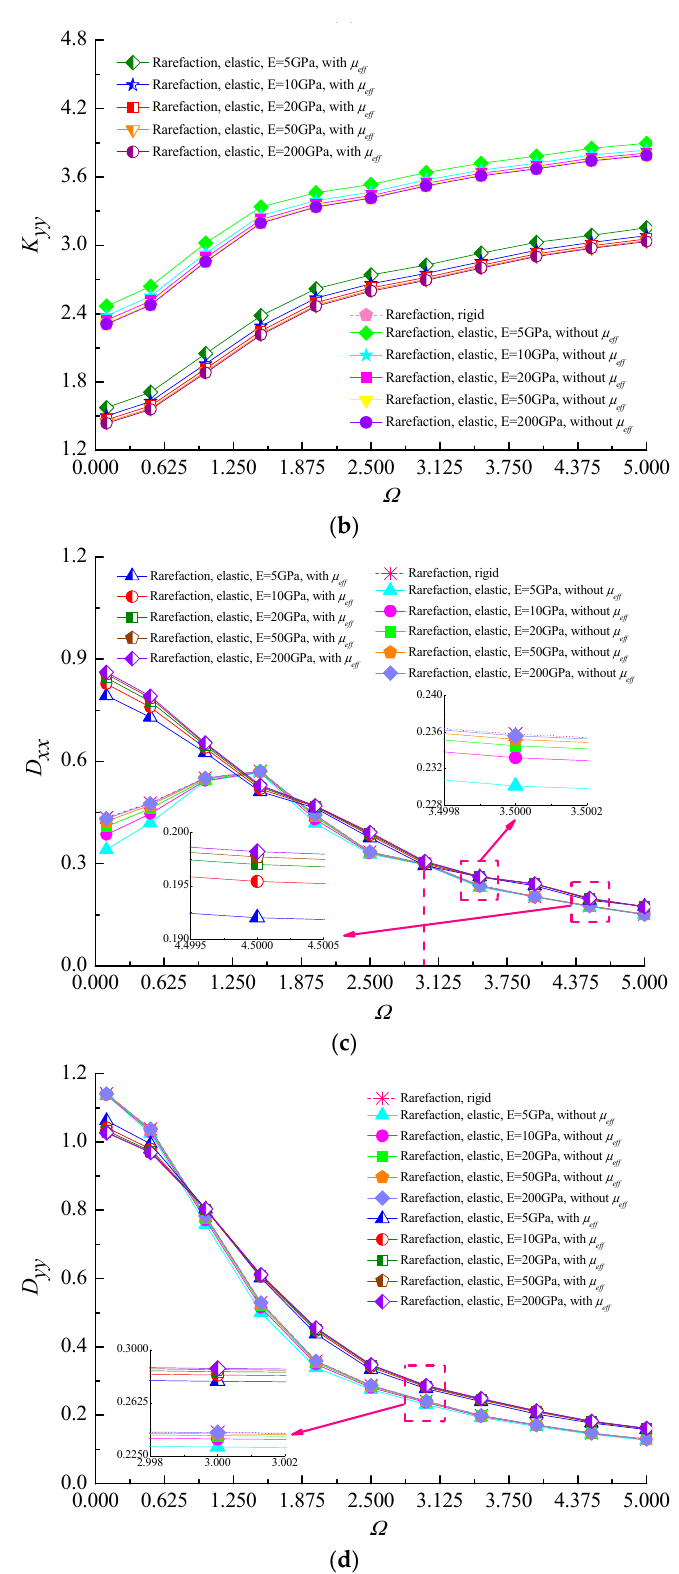
Figure 9. Variation of dynamic stiffness and damping coefficients with the perturbation frequency for different moduli of elasticity of liner material. ( a ) K xx vs. Ω ; ( b ) K yy vs. Ω ; ( c ) D xx vs. Ω ; ( d ) D yy vs. Ω ( ε = 0.7, Λ = 80, υ = 0.3).